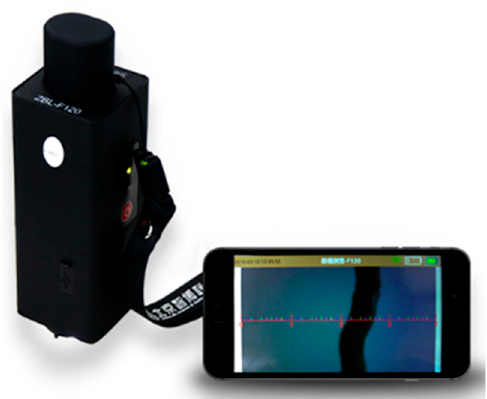
Figure 4. Test setup and instrumentation.